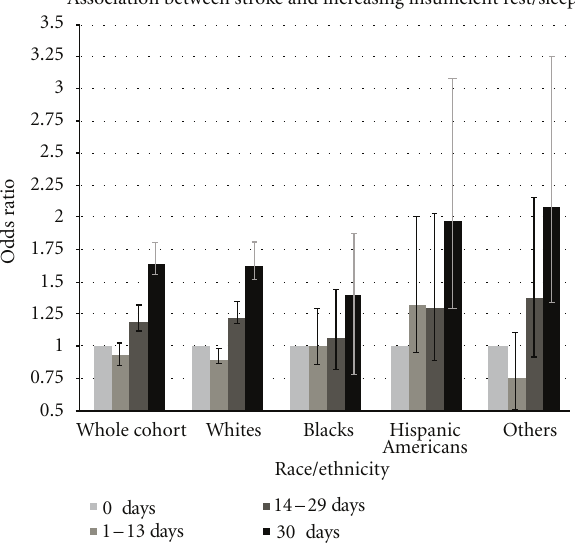
Figure 2: Association between insu ffi cient rest/sleep and stroke. X - axis: categories of insu ffi cient rest/sleep within the whole popula- tion and by di ff erent race-ethnicities. Y -axis: odds ratio of stroke prevalence (95%